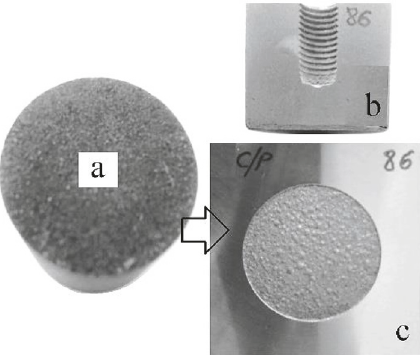
Figure 14: Electrode and machined workpiece produced from a P/C composite material with a copper content of 86% wt: (a) machine surface of electrode, (b) electrode cross section, and (c) machined SAE 1040 steel